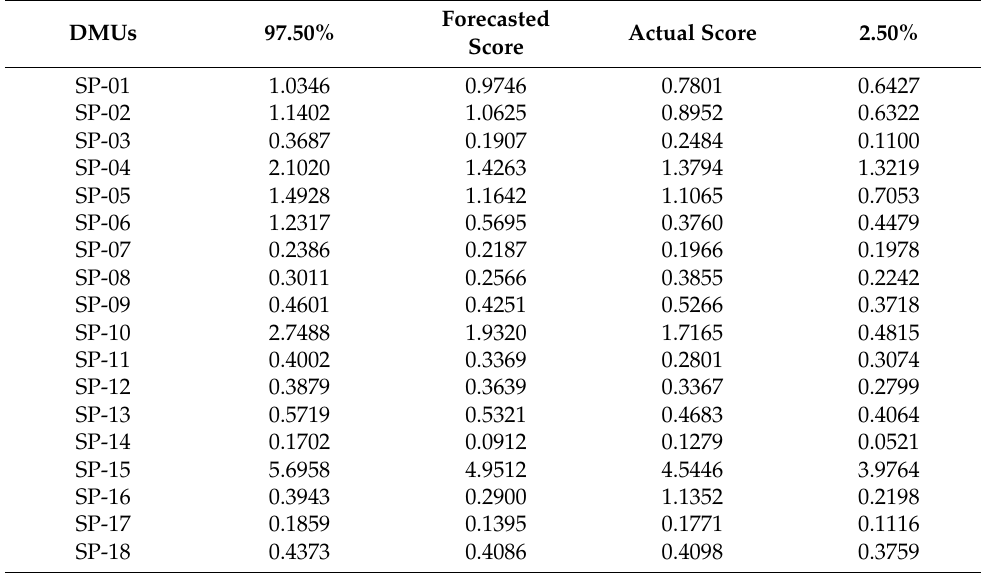
Table 6. Forecast scores by the Lucas weight model, actual scores, and confidence interval in